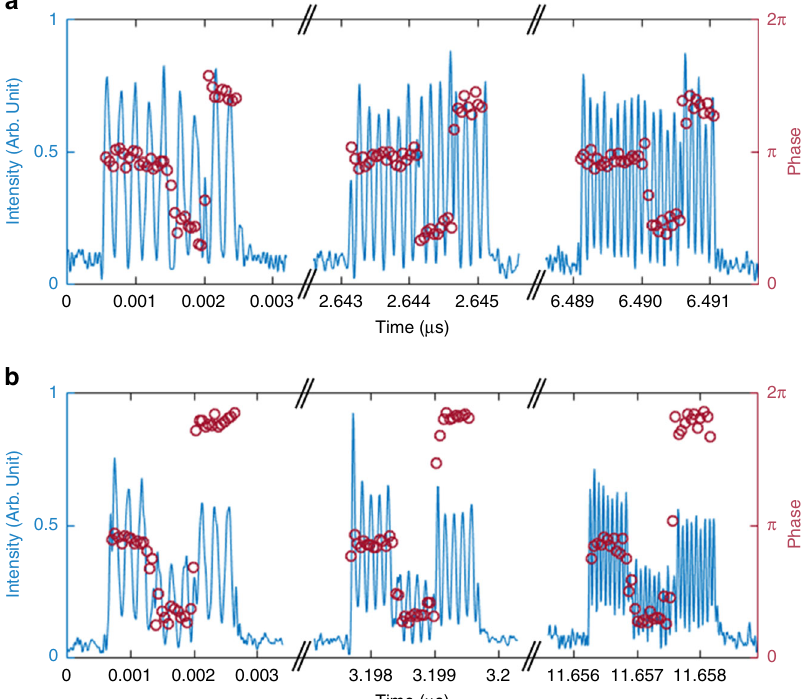
Fig. 5 Demonstration of RF AWG on a carrier. a Examples of arbitrary phase modulated signals on a carrier (QPSK, 8 Gbits/s). The carrier frequencies are 5 GHz, 7 GHz, and 10 GHz from left to right, respectively. b examples of arbitrary amplitude and phase modulated signals on a carrier (8 QAM, 10 Gbits/s). The carrier frequencies are 5 GHz, 8 GHz, and 15 GHz from left to right,